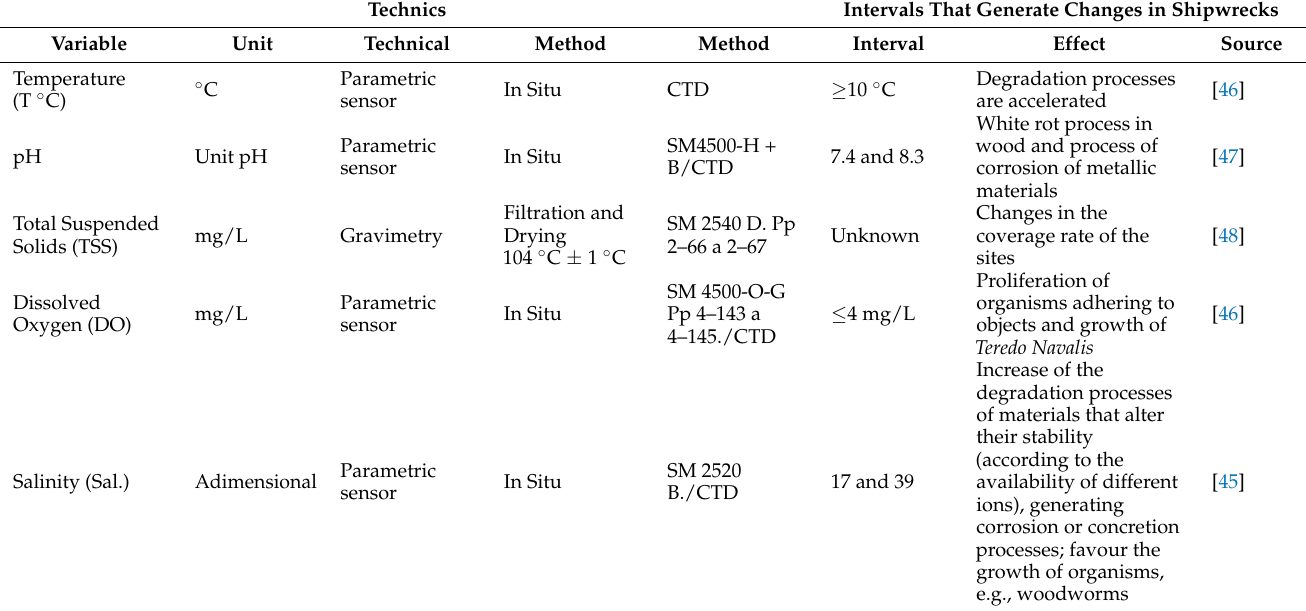
Table 3. Techniques used to measure considered physicochemical and biological variables in the investigated sites. Their effects on the shipwrecks are also